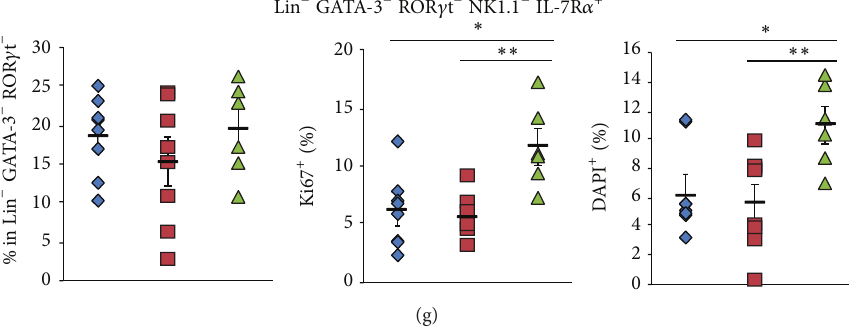
Figure 5: Normal intestinal ILC compartments in CXCR6-deficient mice are compensated by higher proliferative capacities of in situ progenitor cell. (a) Percentages of ILC subsets in Lin − (as defined in Figure 3(b)) in adult LP from Rag2 − / − Cxcr6 +/+ (wt, blue losange), Cxcr6 Gfp/+ (HZ, red square), or Cxcr6 Gfp/Gfp (KO, green triangle) adult mice. (b) Histograms depicting levels of CD62L, CD69, CD44, CXCR6- GFP, and 𝛼 4 𝛽 7 in Lin − (filled gray) or ILC subsets (as defined in Figure 3(b)) in adult LP (upper panels) or mesenteric lymph nodes (mLN, lower panels) from Rag2 − / − Cxcr6 Gfp/Gfp mice. (c) Histograms of total LP Lin − cells (filled gray) or ILC2 cells (red line) for Ki67 expression and DAPI levels. ((d), (e)) Percentages of Ki67 + cells (d) and DAPI + cells (e) among ILC subsets (as defined in Figure 4(b)) in LP from Rag2 − / − Cxcr6 +/+ (wt, blue losange), Cxcr6 Gfp/+ (HZ, red square), or Cxcr6 Gfp/Gfp (KO, green triangle) adult mice. (f) Flow cytometry of LP in situ ILCP (upper panel) and CXCR6-GFP and ID2-YFP expression of LP in situ ILCP (lower panels) from Cxcr6 Gfp/+ Id2 Yfp/+ mice. (g) Percentages of IL-7R 𝛼 + precursors in Lin − (left), Ki67 + (middle), and DAPI + (right) cells among IL-7R 𝛼 + precursors in LP from Rag2 − / − Cxcr6 +/+ (wt, blue losange), Cxcr6 Gfp/+ (HZ, red square), or Cxcr6 Gfp/Gfp (KO, green triangle) adult mice. Results are from 3 pooled experiments ((a), (c), (d): wt: 𝑛 = 9 , HZ: 𝑛 = 9 , KO: 𝑛 = 8 ) or from 2 pooled experiments ((e), (f), GF, wt: 𝑛 = 8 , HZ: 𝑛 = 8 , KO: 𝑛 = 6 ) or are representative of 3 experiments (b). In ((a), (d), (e), (g)), each dot represents a single mouse. Statistical data are displayed with mean and SEM (Student’s unpaired bilateral test, ∗ 𝑝 < 0.05 ; ∗∗ 𝑝 < 0.01